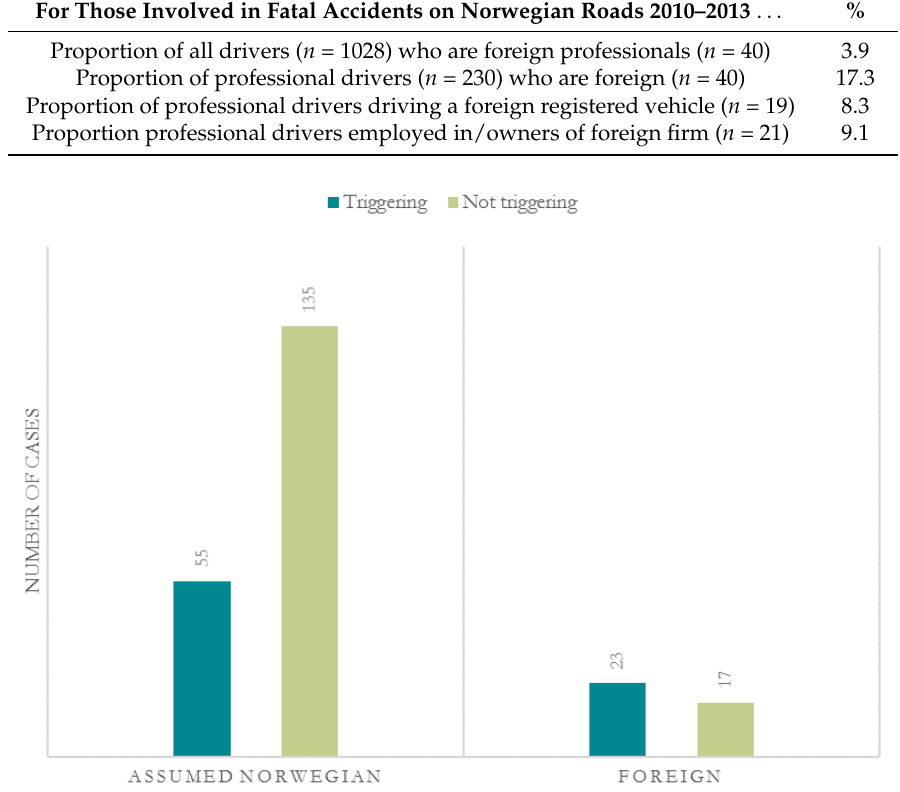
Table 4. Proportions of drivers involved in fatal accidents on Norwegian roads between 2010 and 2013. For Those Involved in Fatal Accidents on Norwegian Roads 2010–2013 . . . % Proportion of all drivers ( n = 1028) who are foreign professionals ( n = 40) 3.9 Proportion of professional drivers ( n = 230) who are foreign ( n = 40) 17.3 Proportion of professional drivers driving a foreign registered vehicle ( n = 19) 8.3 Proportion professional drivers employed in/owners of foreign firm ( n = 21)